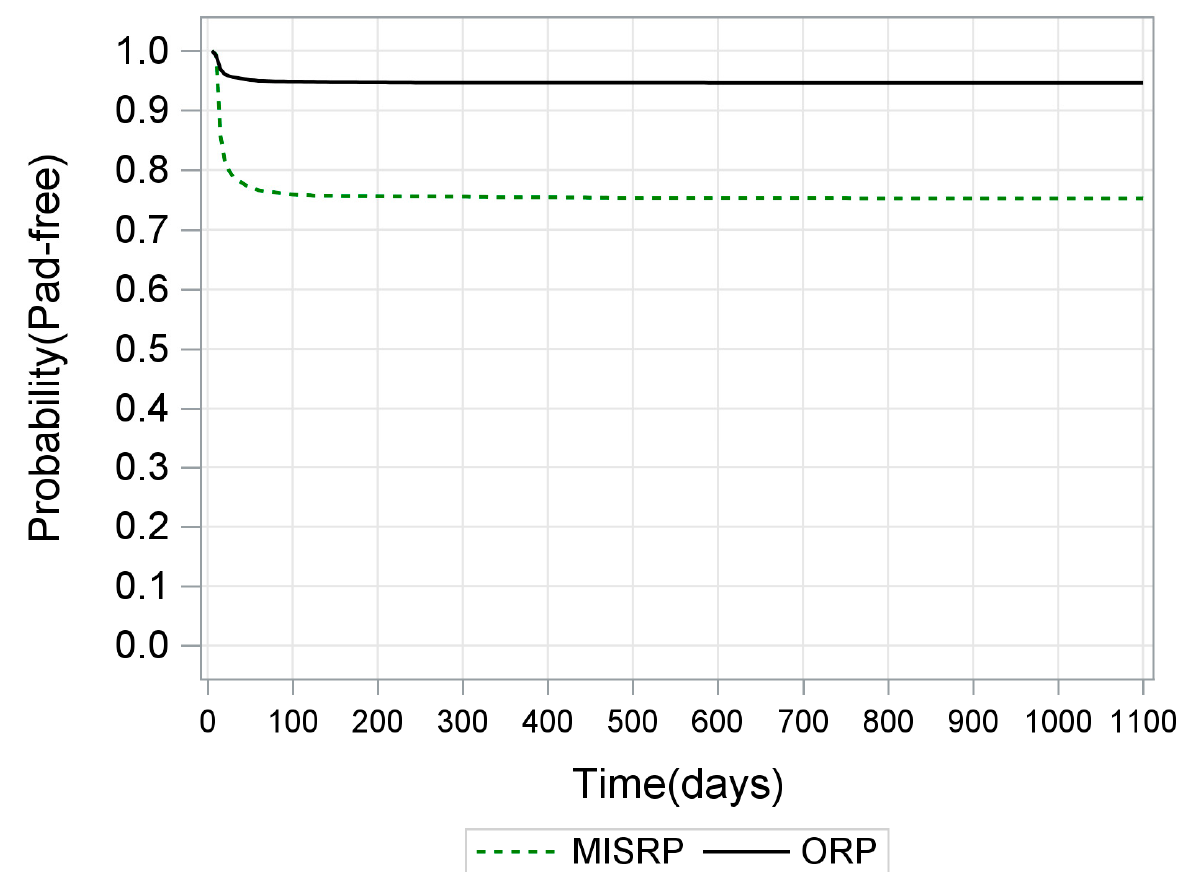
Figure 1. Lifetable analyses on the daily proportion of prostate cancer patients with no incontinence pad prescription (pad-free) from the surgery day through 36 months (1080 days) follow-up. Table 1. Sample characteristics and incontinence pad prescription among prostate cancer patients underwent radical pros ‐ Total number of pad prescriptions, total number and rate of prescribed pads are tatectomy between 2012–2015 in Austria and cancer ‐ free control men. presented restricting to those who received at least one prescription (Table